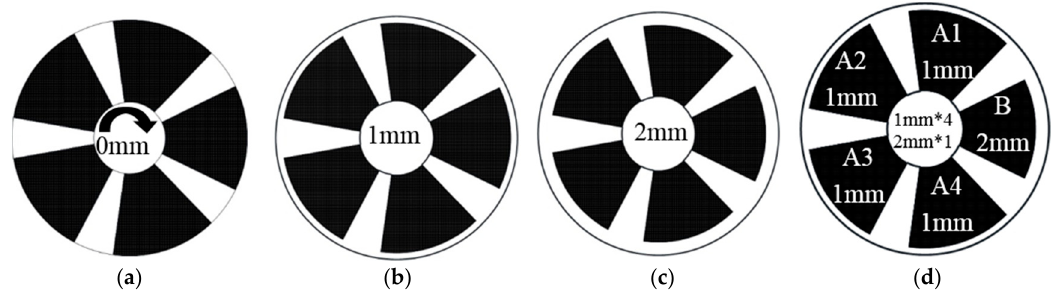
Figure 2. Schematic of tip clearance types: ( a ) 0 mm; ( b ) 1 mm; ( c ) 2 mm and ( d ) unsymmetrical tip.